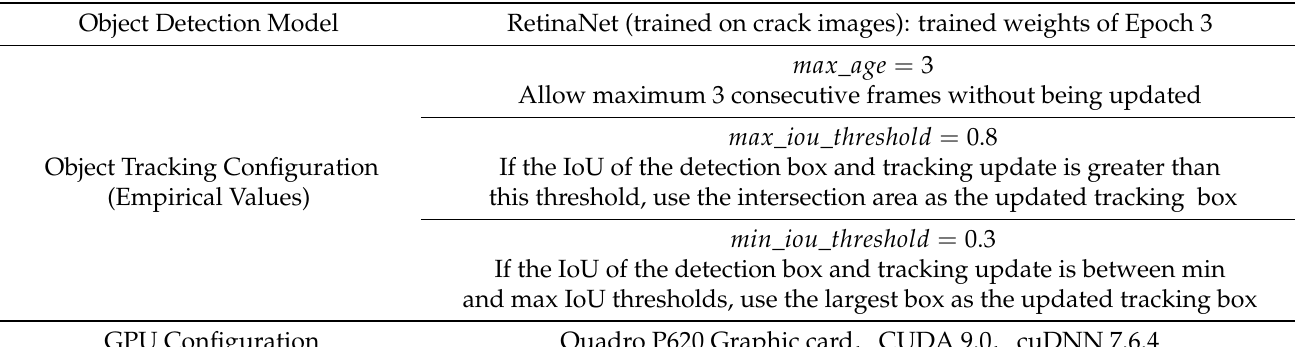
Table 5. Object tracking test environment and